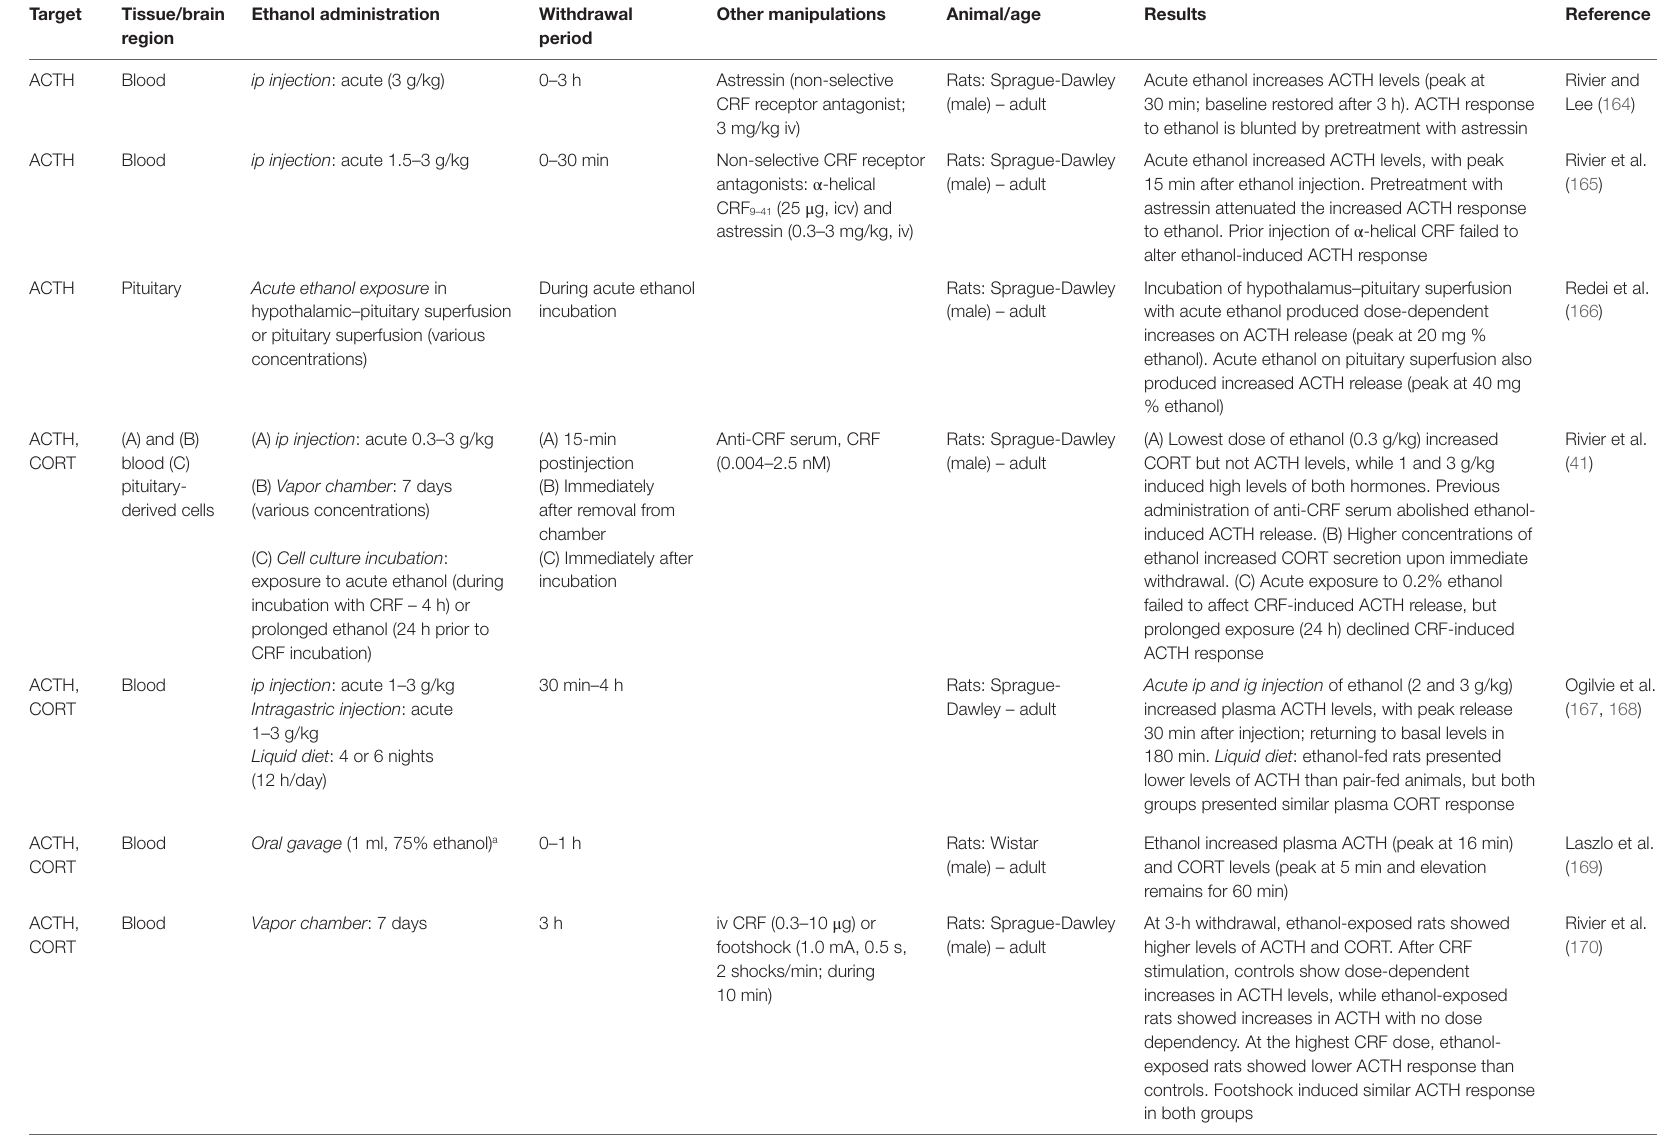
TABLe 3 | Consequences of ethanol exposure on CRF/urocortin